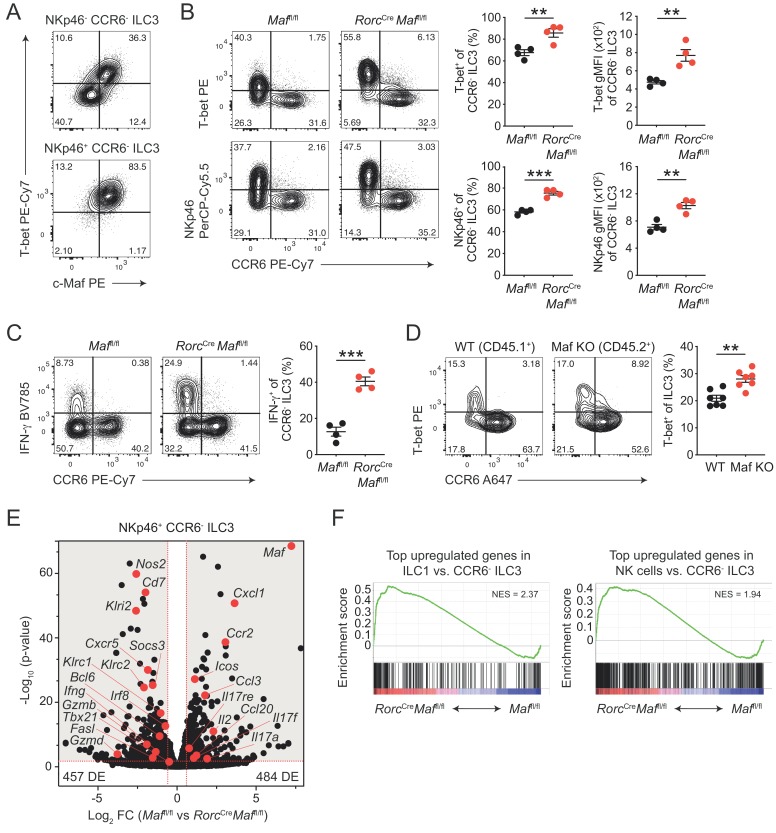
CCR6- ILC3s acquire a hyper type 1 phenotype in the absence of c-Maf.(A) Representative flow cytometric profiles of T-bet vs. c-Maf expression by siLP NKp46+ and NKp46- CCR6- ILC3s. (B) T-bet and NKp46 expression (frequency and gMFI) by siLP CCR6- ILC3s of RorcCreMaffl/fl and control mice. Representative flow cytometric profiles are shown on the left; quantification on the right (n = 4, mean ± SEM, **p<0.01, ***p<0.001). (C) Frequency of IFN-γ positive cells among siLP CCR6- ILC3s of RorcCreMaffl/fl and control mice after ex vivo restimulation with PMA/ionomycin and IL-23. Representative flow cytometric profiles are shown on the left; quantification on the right (n = 4, mean ± SEM, ***p<0.001). (D) Analysis of mixed bone marrow chimeras of CD45.1+ wild-type and CD45.2+
RorcCreMaffl/f (Maf KO) bone marrow cells. Pregated on viable Lin- CD127+ CD90.2+ RORγt+ cells. Recipient mice were CD90.1 positive. Representative flow cytometric profiles of T-bet vs. CCR6 expression are shown left; quantification on the right (n = 7, mean ± SEM, **p<0.01). All statistical differences were tested using an unpaired Students’ t-test (two-tailed). (E) NKp46+ CCR6- ILC3s were sorted from siLP of RorcCreMaffl/fl and control mice and subjected to RNA sequencing. Vulcano plot showing comparison of gene expression between c-Maf-deficient and control NKp46+ CCR6- ILC3s. Data represent the combined analysis of three biologically independent samples. Genes considered significant (FC > 1.5, FDR < 0.05) fall into the grey background, while selected genes are highlighted in red. (F) Gene set enrichment plots showing enrichment of ILC1 and NK cell signature genes in c-Maf-deficient vs. control NKp46+ CCR6- ILC3s (FDR < 0.01). Normalized enrichment score (NES).